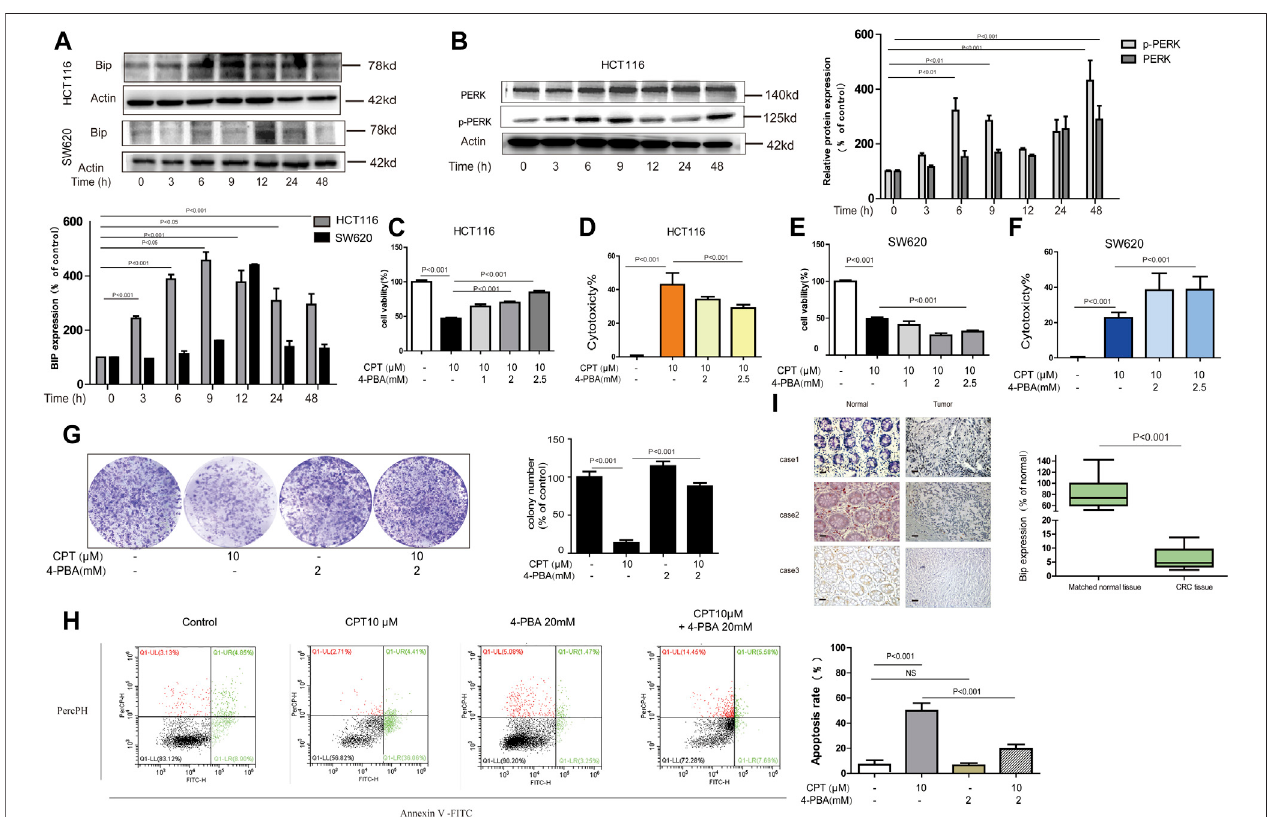
FIGURE 6| InHCT116cell,ERstressmediatestheanti-tumoreffectofCPT.WesternblotwasusedtodetermineBIPinHCT116cellsandSW620celllysatestreatedwith CPT (10 μ M) for different times (A) . PERK and p-PERK was detected in HCT116 cells treated as in (A) using western blotting analysis (B) . In the presence or absence of 4-PBA (1, 2, and 2.5 mM), HCT116 cells, and SW620 cells treated or untreated with CPT (10 μ M) were cultured for 48 h and tested by MTT assay (C, E) and LDH assay (D, F) . In the presence or absence of 4-PBA (2 mM), the colony formation assay of HCT116 cells treated with or without CPT (10 μ M) was performed and quanti fi ed with Image J (G) . ApoptosisofHCT116cellstreatedasin (G) wasdetectedby fl owcytometry (H) .Theimmunohistochemicalanalysisoftheclinicalsampleswereperformed,andtheexpressionof BIPwasdetectedinthetumortissueandthecorrespondingpara-cancertissue,andthequanti fi cationanalysiswasperformedwithImageJ (I) .CPT,cryptotanshinone;ERstress, endoplasmic reticulum stress; LDH, lactate